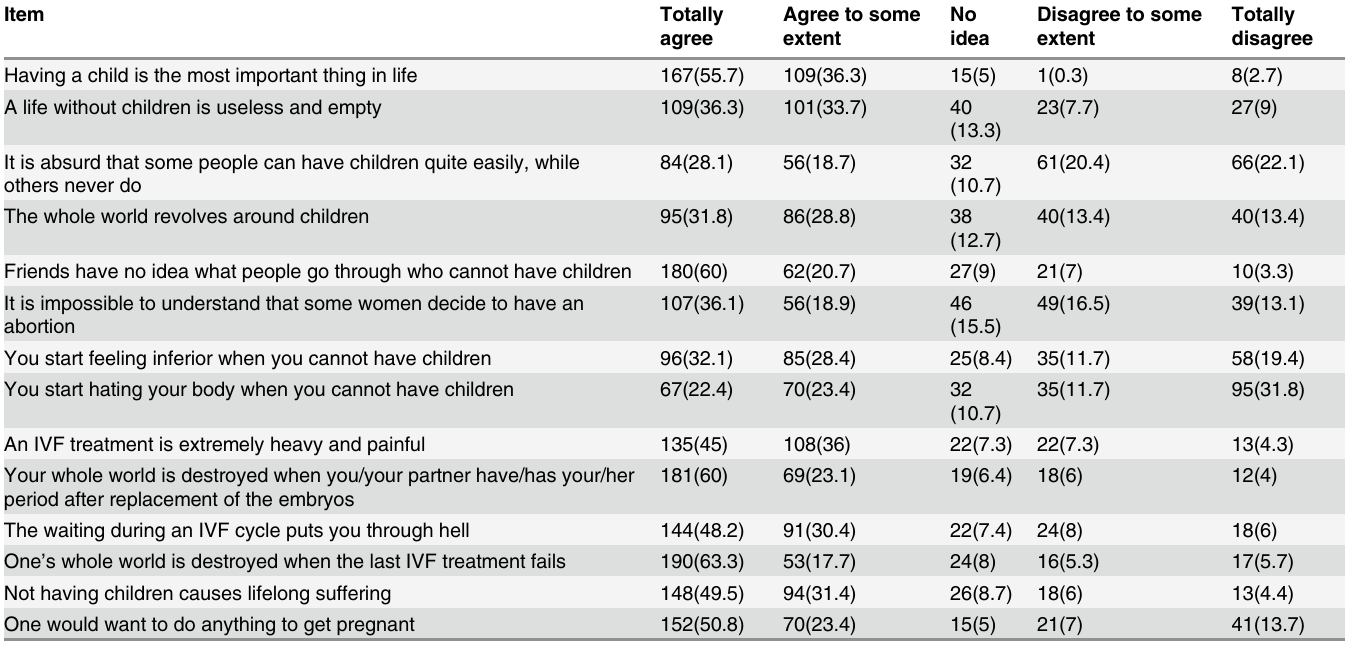
Table 1. Items of irrational parenthood cognition questionnaire and the answers of participants to